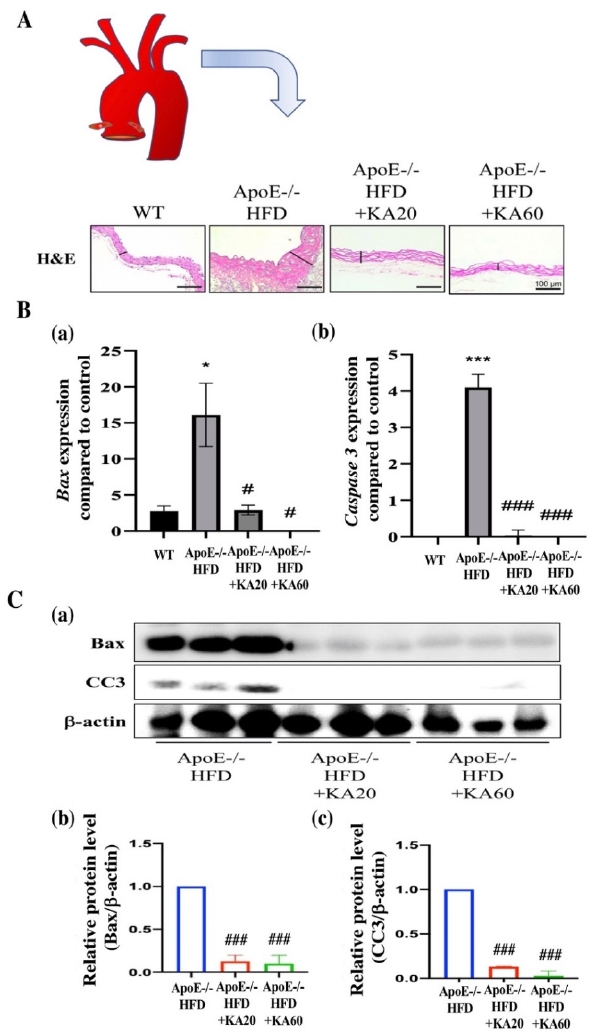
Figure 5. Kansuinine A (KA) reduces atherosclerotic lesions. Results showing the mRNA and protein expression of Bax and caspase-3 in ApoE − / − mice. ApoE − / − mice fed a high-fat diet (HFD) or HFD supplemented with 20 or 60 µ g/kg KA (20 KA+HFD and 60 KA+HFD, respectively) per g of body weight three times a week for 15 weeks. ( A ) Hematoxylin and eosin (H&E) staining of representative atherosclerotic lesions in aortic root from WT and ApoE − / − mice. Lesion width of aortic root highlighted with black. Scale bars, 100 µ m. ( B ) mRNA expression of Bax ( a ) and caspase-3 ( b ) were evaluated using RT-qPCR. ( C ) Protein expression of Bax ( b ) and cleaved caspase-3 (CC3, c ) were evaluated using western blotting ( a ). β -actin was used as the control. Data are presented as means ± standard deviation (n = 3). p Values were determined using the Student’s t -test. * p < 0.05, *** p < 0.001 vs. WT mice; # p < 0.05, ### p < 0.001 vs. ApoE − / − mice fed a high-fat diet (HFD